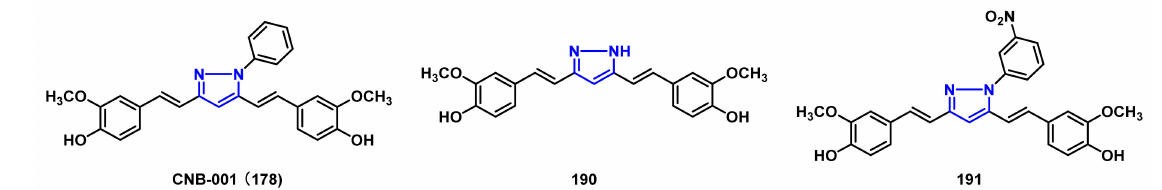
Figure 16. Chemical structures of pyrazole-containing antioxidants.